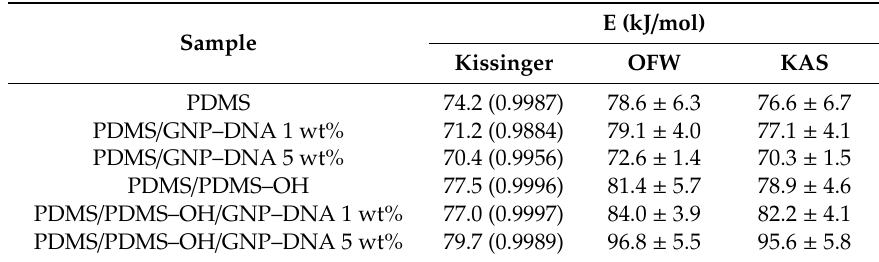
Table 3. Activation energies for the curing process of PDMS (Sylgard 184) and PDMS / PDMS–OH (75:25 w / w) nanocomposite systems estimated by the Kissinger method (with R-squared values from linear regression) and the isoconversional methods, Ozawa–Flynn–Wall (OFW) and Kissinger–Akahira–Sunose